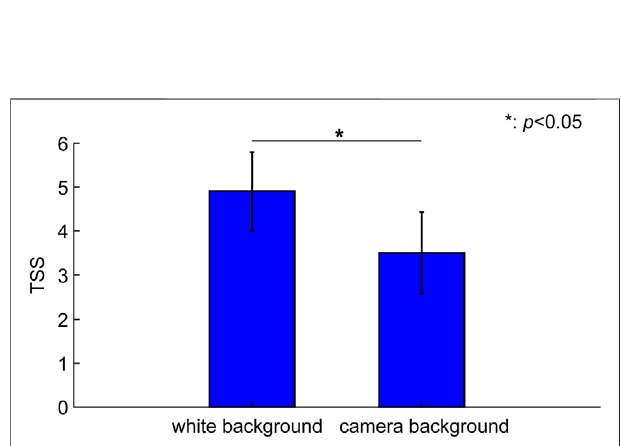
FIGURE6| AverageMiseryScale(MISC)at20 minsafterthestartofthe task. The median MISC at 20 min was signi fi cantly lower in the camera background condition than in the white background condition. Error bars indicate the standard error. Asterisk indicates statistically signi fi cant difference (* p < 0.05).